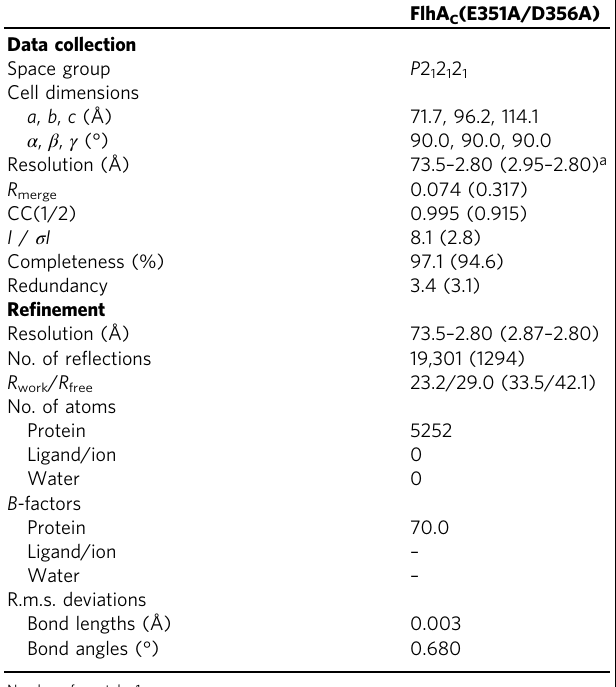
Table 1 Data collection and re fi nement statistics.